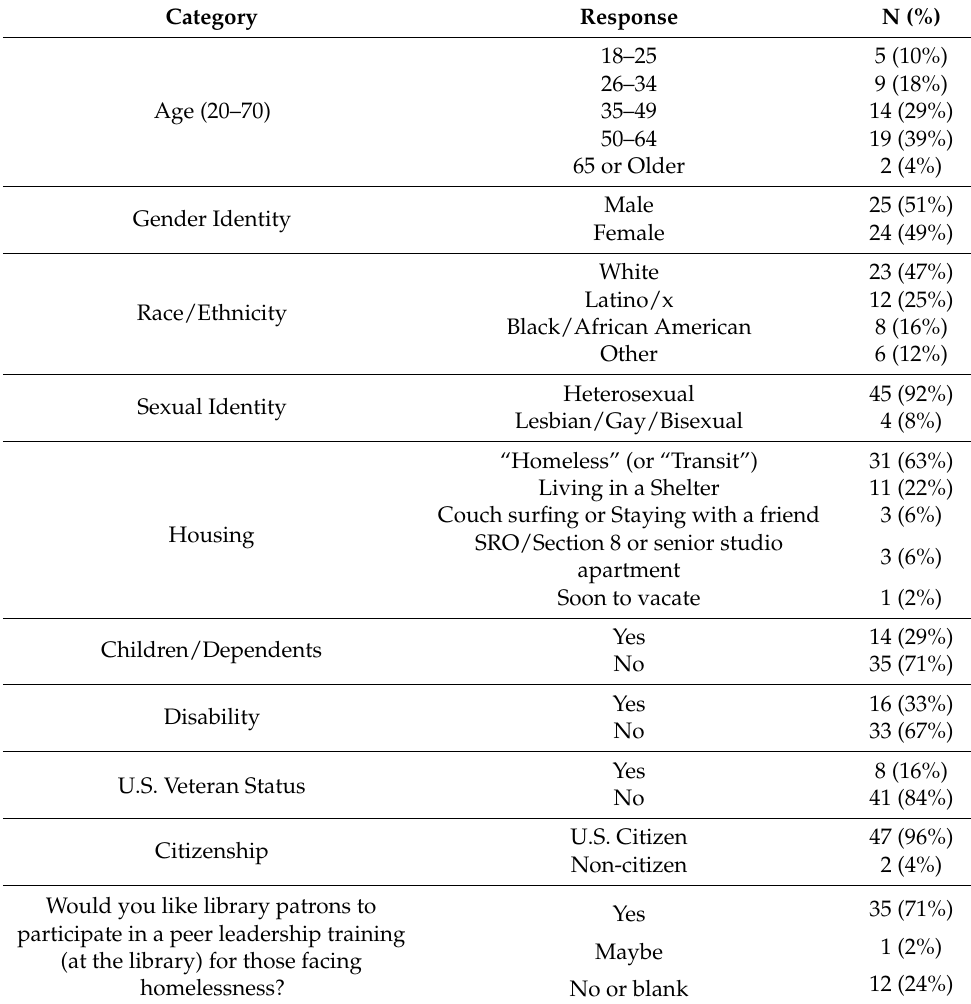
Table 1. Socio-demographic characteristics of library patron survey participants ( n =